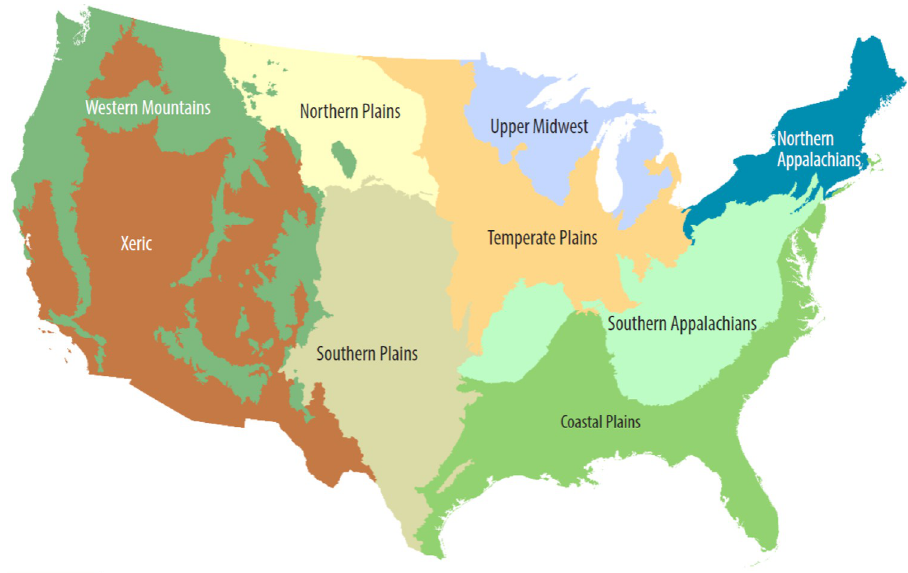
Fig 3. Map of the USA ecoregions. Adapted from USEPA (2020) [74]. For information on the sample site locations see Kaufmann et al . (2022a) [76].